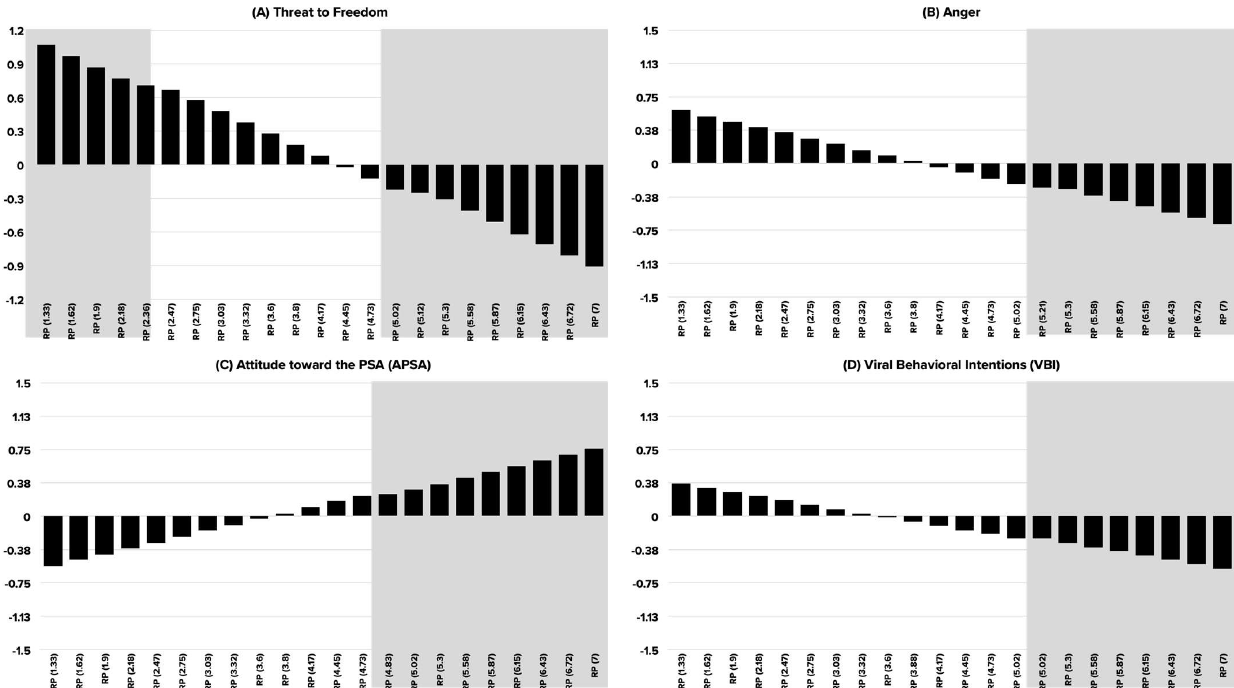
Figure 3. Johnson-Neyman regions of significance with unstandardized beta coefficients for the effect of persuasive appeal on DVs at different values of risk perception (moderator). Values reported in the graph indicate unstandardized beta coefficients. Shaded area indicates significant regions.